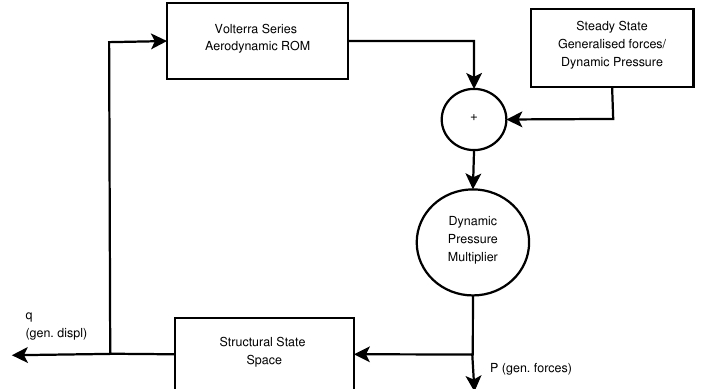
Figure 5. Outline of the time domain Volterra series based